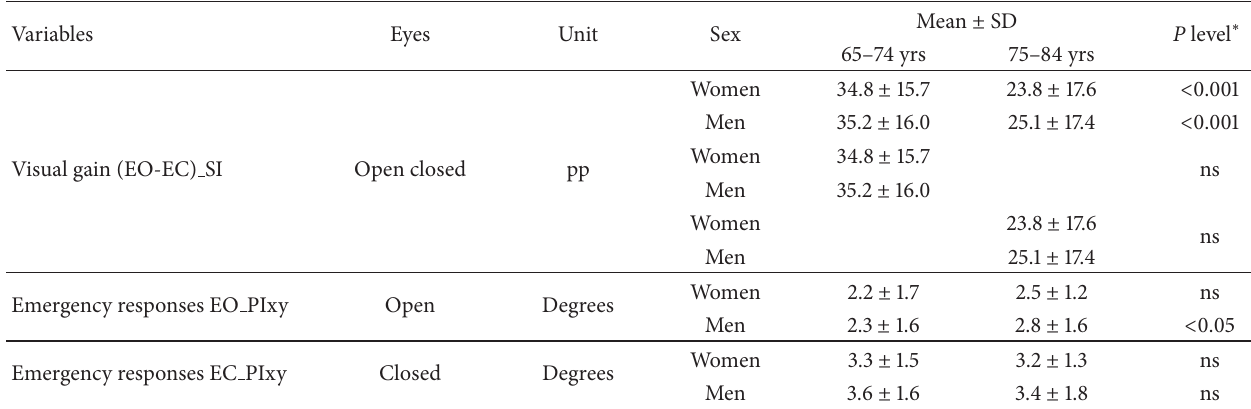
Table 3: The visual gain and the emergency responses in the single stance test (ST). Each variable in the first column is identified by a compound name which includes the eye condition and the name of the basic variable.